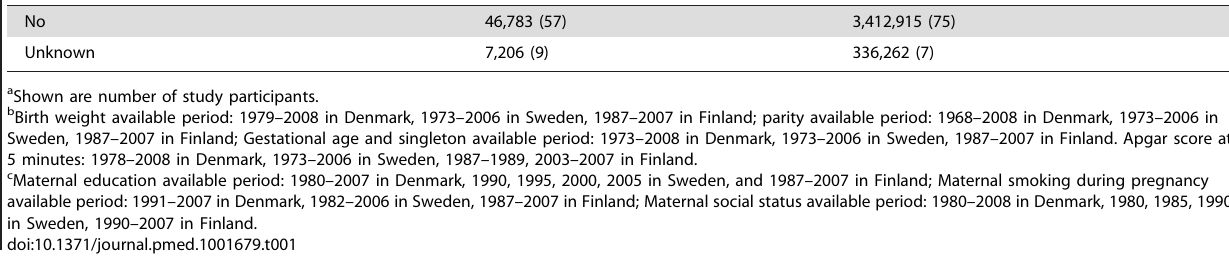
Table 2. Mortality rate ratios after parental death in childhood, by type of death.